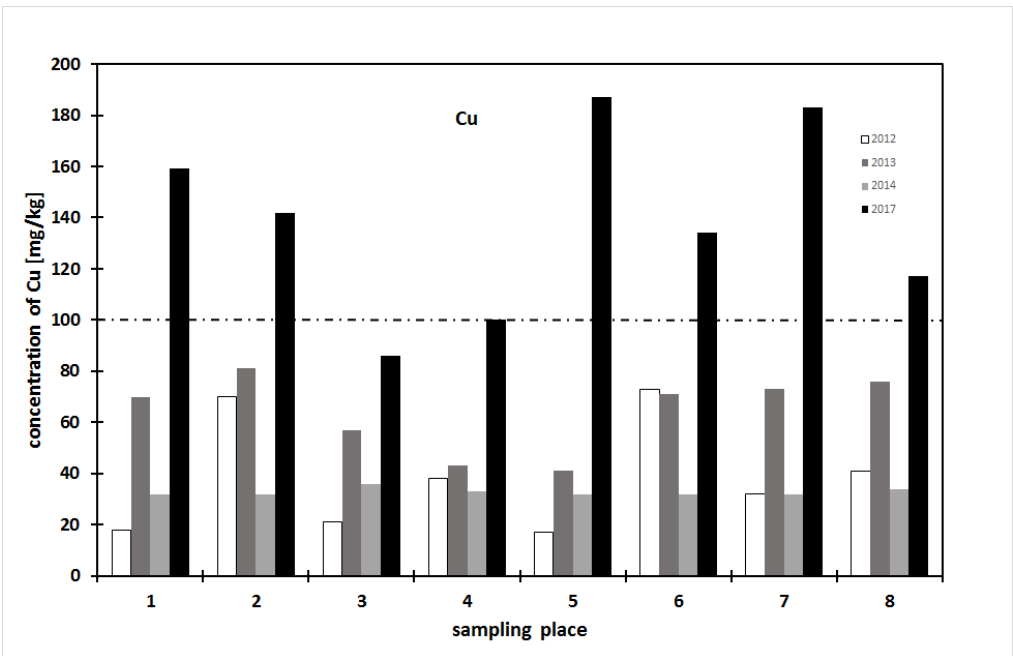
Figure 3. Content of Cu in sediments at individual sampling places in 2012, 2013, 2014, and 2017. The dashed line represents the limits for risk elements according to Annex No. 1 of the Czech Decree 257/2009 Coll. [30] . Limit of quantification <1 mg/kg.